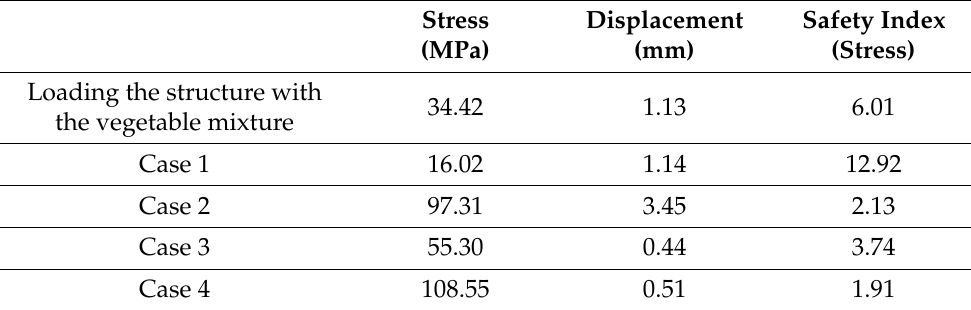
Table 1. List of equivalent stresses and